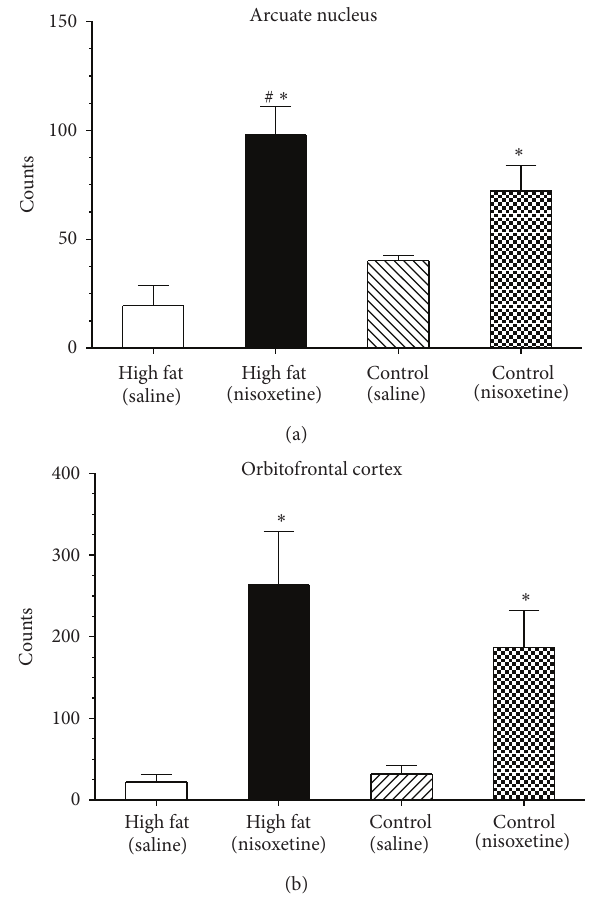
F 6: Average immunoreactive c-Fos counts in the arcuate nucleusandorbitofrontalcortex.Immunopositivecellcountsmeans SE. ere was an overall increase in cell number in animals injected with nisoxetine (3mg/kg), which is indicated by ). (a) Arcuate nucleus of the hypothalamus. Planned compar- ± isons revealed a signi�cant effect for animals with high-fat diet exposure and nisoxetine. # indicates a difference ( 0.05 between High Fat (Nisoxetine) and control diet (Nisoxetine). (b) Orbitofrontal cortex. ere were no signi�cant differences between diet conditions in this